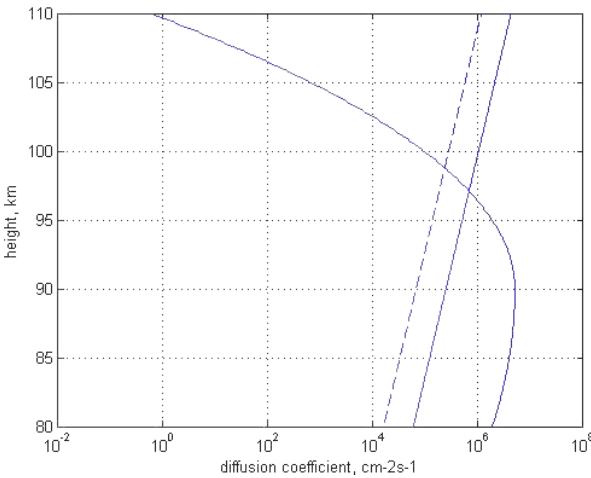
Fig. 1. Height distributions of molecular diffusion coefficients for Ar and He (dashed and solid lines, respectively) and the eddy diffu- sion coefficient (solid